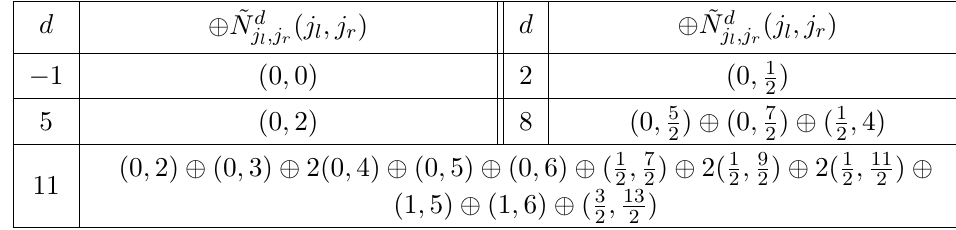
Table 8 . Spectrum of the SCFT of a local P 2 in the presence of a Wilson loop h W Here, d labels BPS states with charge dφ